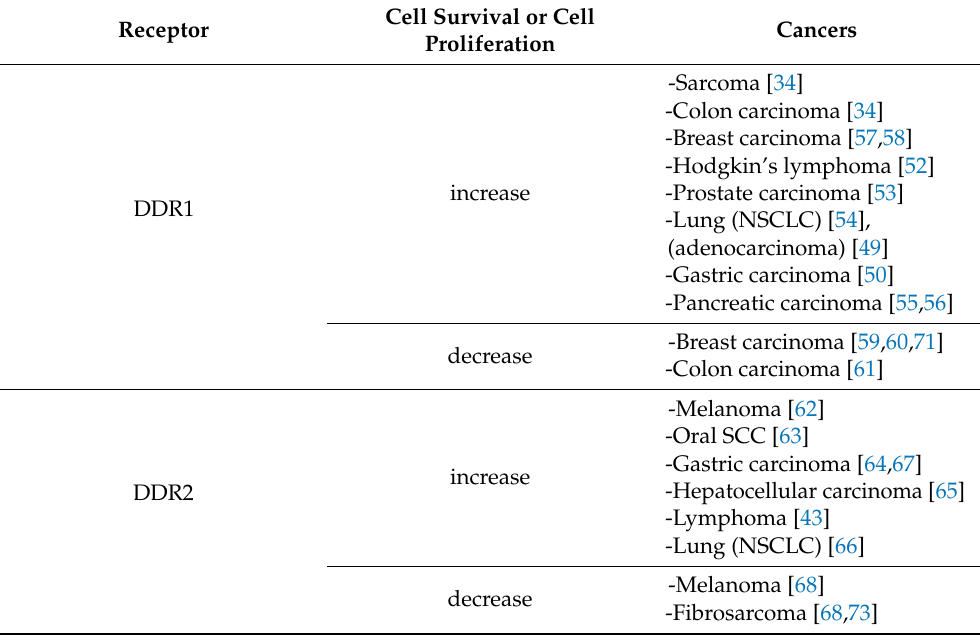
Table 1. Roles of DDRs in tumor cell survival or proliferation. NSCLC, non-small-cell lung cancer; SCC, squamous cell carcinoma. Cell Survival or Receptor